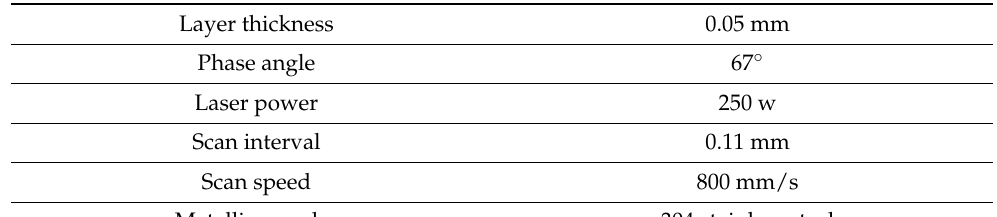
Table 2. Printing process parameters.